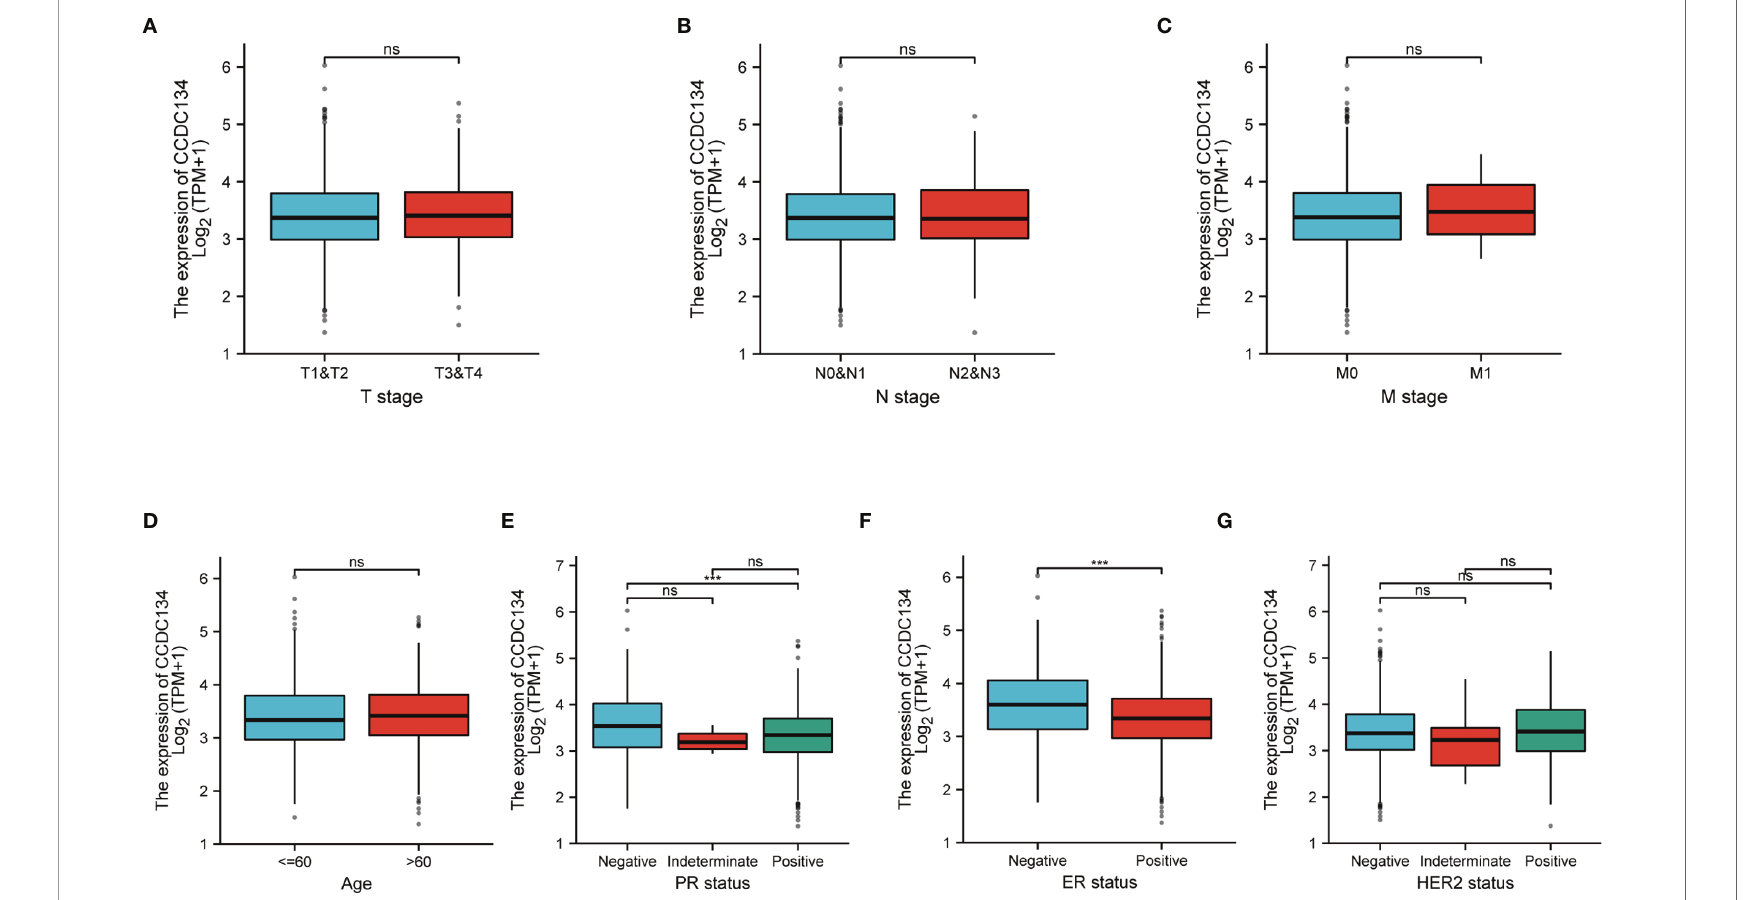
FIGURE 4 | CCDC134 mRNA level relationship with clinical pathological characteristics. There was no signi fi cant difference between CCDC134 mRNA expression and T (A) , N (B) , M (C) level, age (D) and HER2 (G) level. It was negatively correlated with PR (E) and ER (F) status. (ns, p ≥ 0.05;